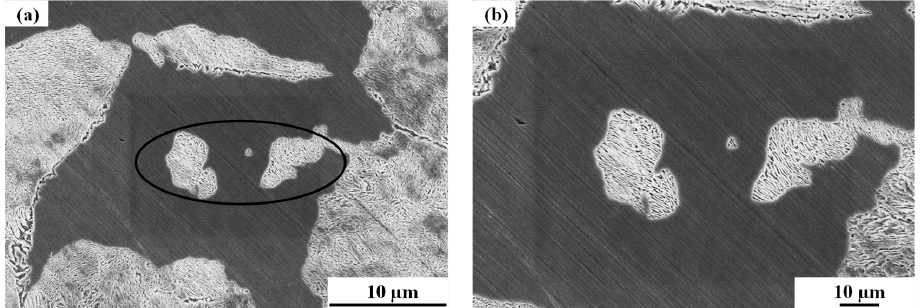
Figure 9. SEM microscopy of isothermal austenite / pearlite transformation at 550 ◦ C for 10 s after austenitizing at 880 ◦ C; ( b ) an enlarged view of the black circle in ( a